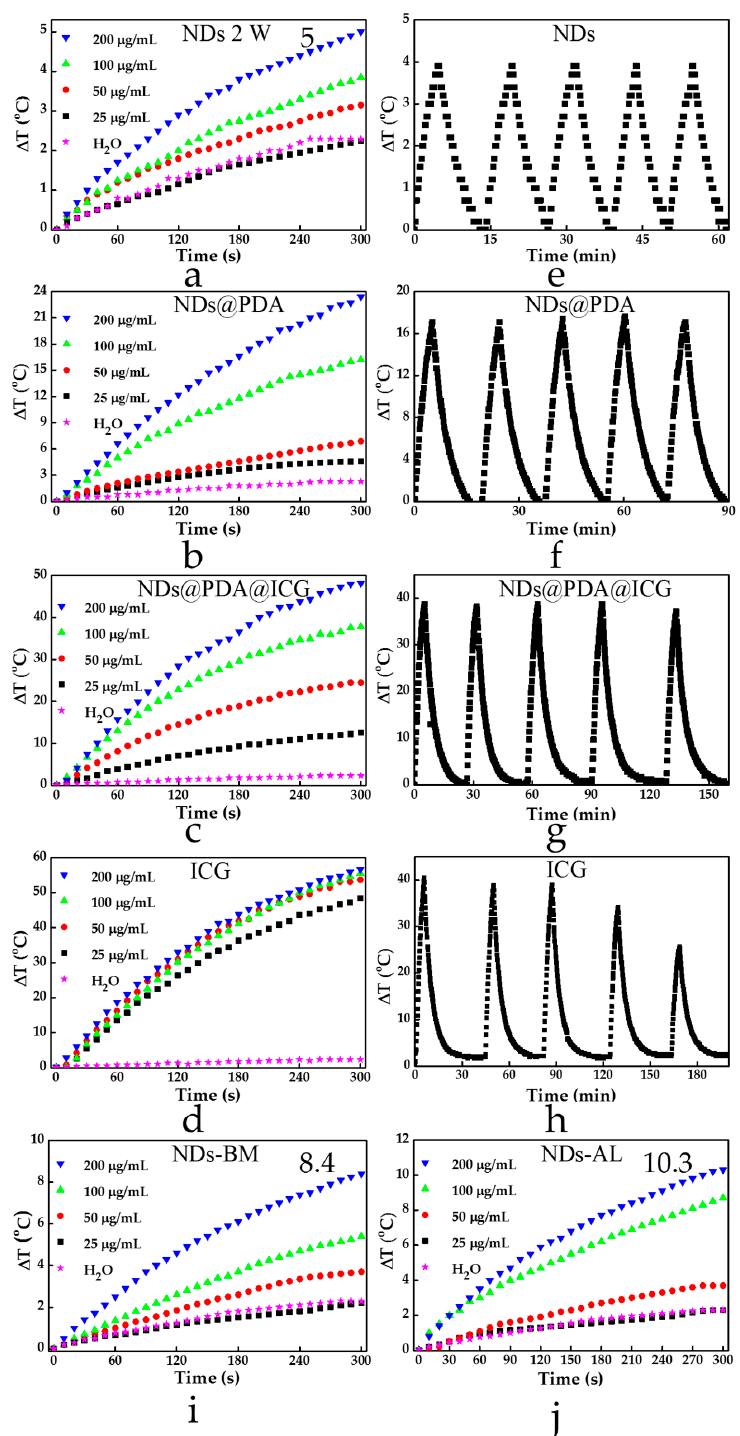
Figure 4. ( a–d ) Increase in solutions’ temperature in time after NIR laser irradiation for different concentrations of ( a ) NDs, ( b ) NDs@PDA, ( c ) NDs@PDA@ICG, and ( d ) ICG alone. ( e–h ) Stability of ( e ) NDs, ( f ) NDs@PDA, ( g ) NDs@PDA@ICG, and ( h ) ICG at 100 µg/mL after five cycles of irradiation. ( i , j ) The photothermal response of ( i ) NDs-BM (alkylated and siliconized; detonation NDs) and ( j ) NDs-AL (hydrogenized and nitrogenized; laser NDs). They exhibit slightly better photothermal properties in comparison to carboxylated NDs. Maximal temperature increase is indicated for ( a ) NDs, ( i ) NDs-BM, and ( j ) NDs-AL at a concentration of 200 µ g/mL reaching 5, 8.4, and 10.3 ◦ C,